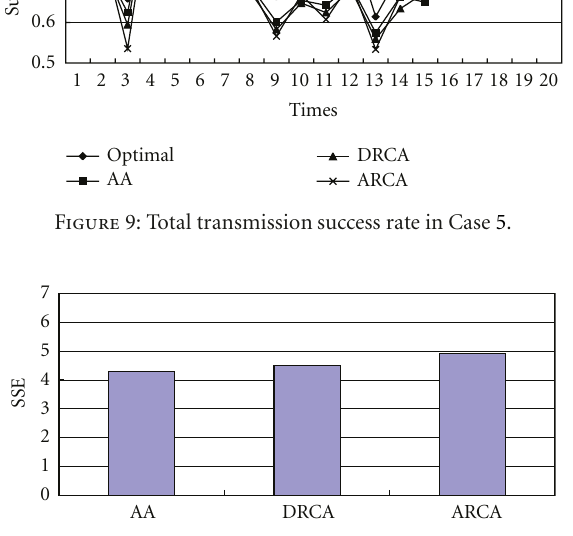
Figure 10: Sum of squared errors in Case